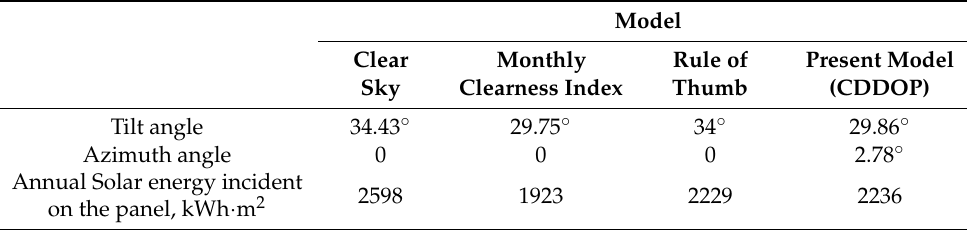
Table 3. A comparison of optimum tilt angle and total incident irradiation on a solar panel